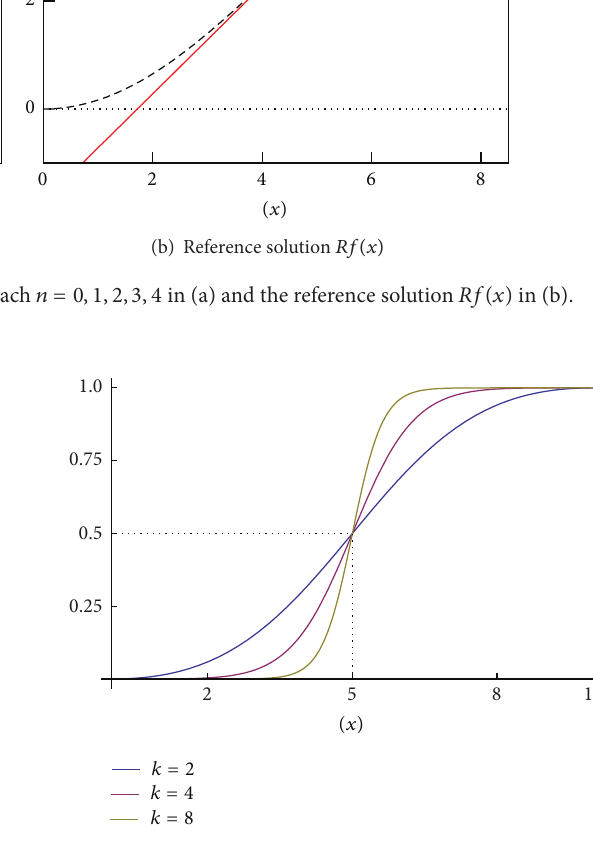
Figure 3: Behavior of the weight function 𝑤 𝐿 (𝑘;𝑥) with 𝐿 = 10 for each 𝑘 = 2, 4, 8